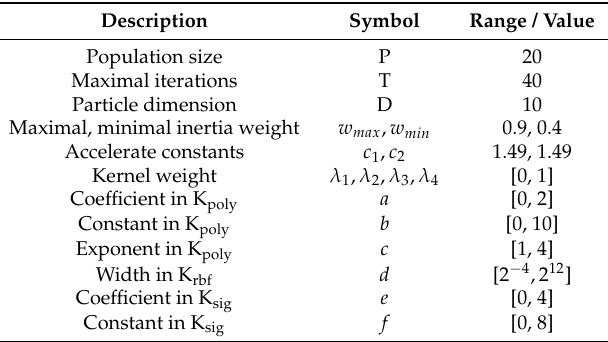
Table 2. Parameters for